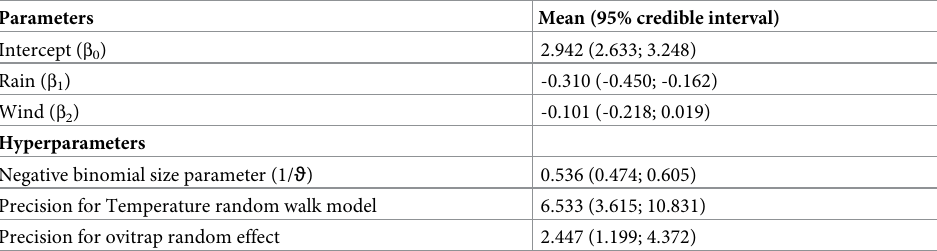
Table 2. Results for the GAMM. Dependent variable is the count of eggs in ovitrap, independent variables are wind, rain considered as fixed effect and temperature as spline function, while the position of ovitraps as randomised effect. The posterior mean values and 95% credible intervals for both parameters and hyperparameters are provided. When the 95% credible interval includes zero there is no statistical support of a correlation between the independent and the dependent